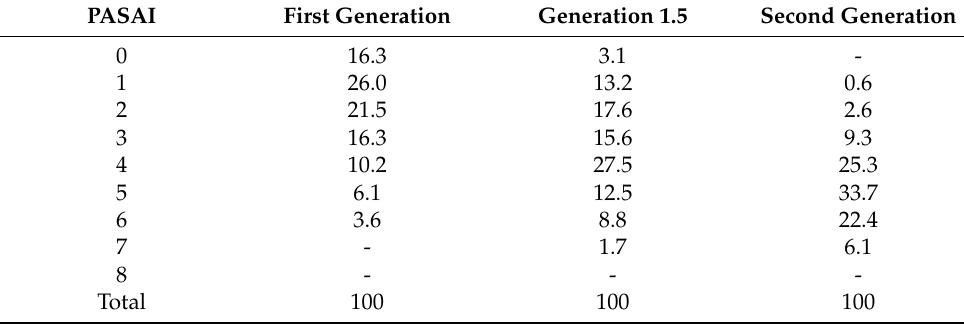
Table A5. PASAI according to generation (%).